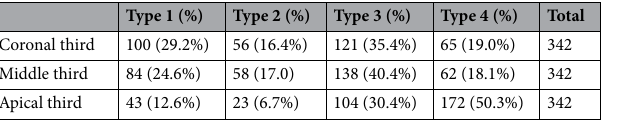
Table 3. Classifications of C-shaped mandibular second molars based on the modified Fan’s